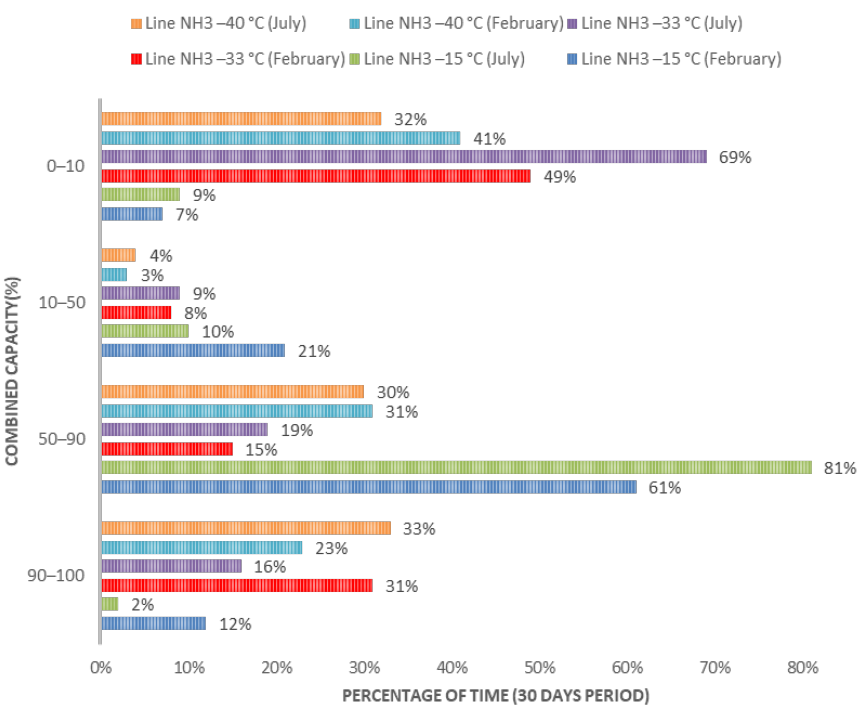
Figure 8. Capacity analysis for refrigeration circuits.